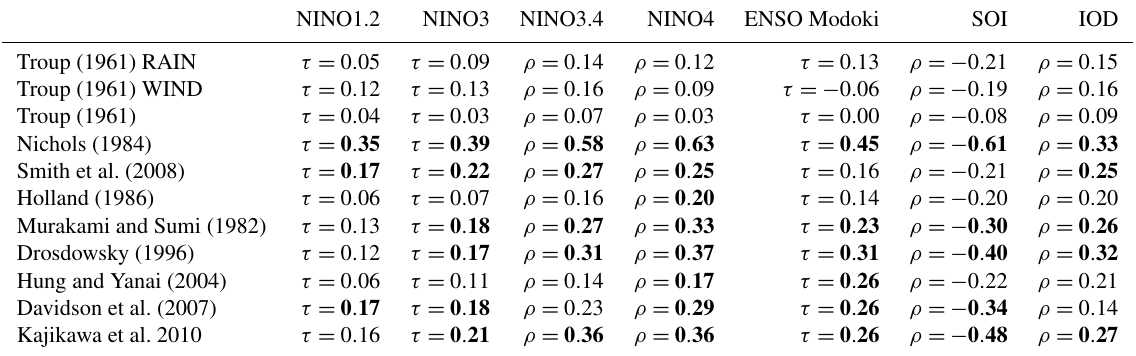
Table 5. Correlation coefficients of September–October–November ENSO indices with monsoon onset dates from each onset dataset. Bolded values indicate statistically significant correlations ( p< 0 .